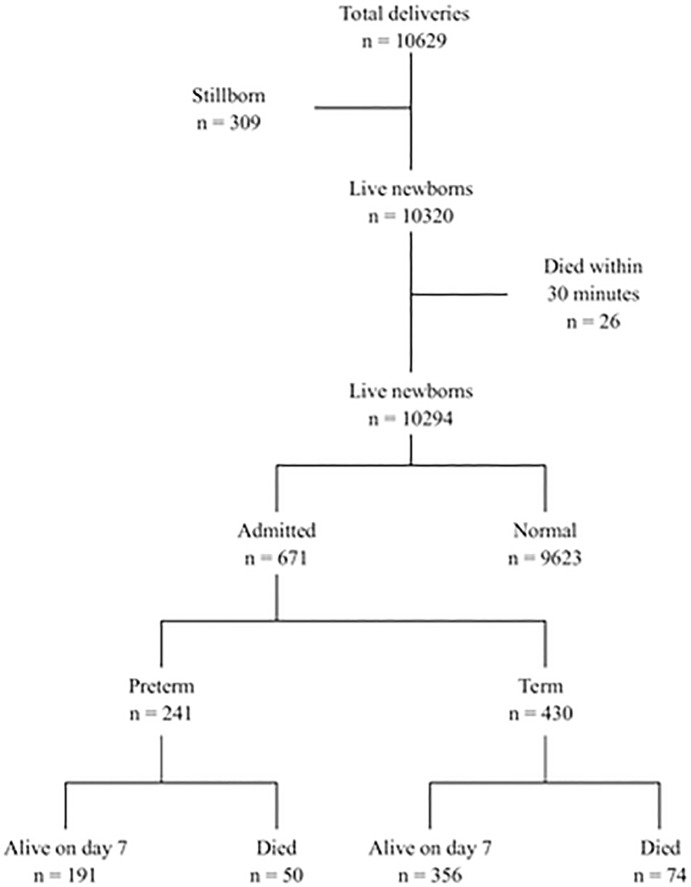
Flow diagram of newborn delivered and outcome after 7 days.